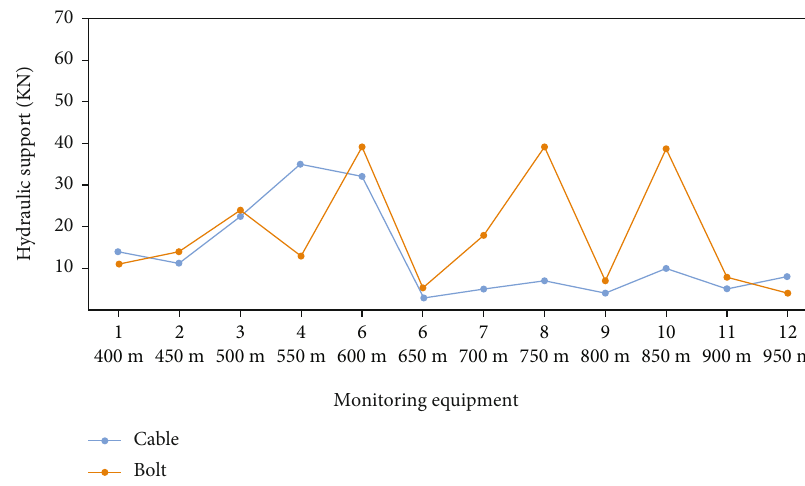
Figure 13: 42108 auxiliary side anchor cable/bolt stress line